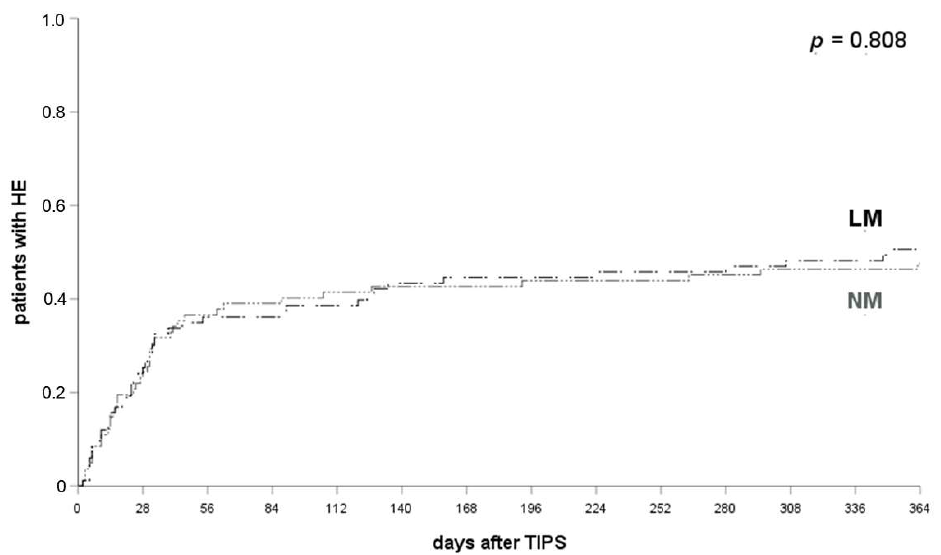
Figure 1. HE occurrence in patients with LM and NM. HE occurred in 38.8% of patients with NM and 33.7% of patients with LM at 1 month ( p = 0.581), 44.3% and 40.9% at 3 months ( p = 0.723) and 53.7% and 50.6% at 12 months after their TIPS implantation ( p = 0.808). log-rank test applied. HE, hepatic encephalopathy; LM, lactulose monoprophylaxis; NM, no prophylactic medication.